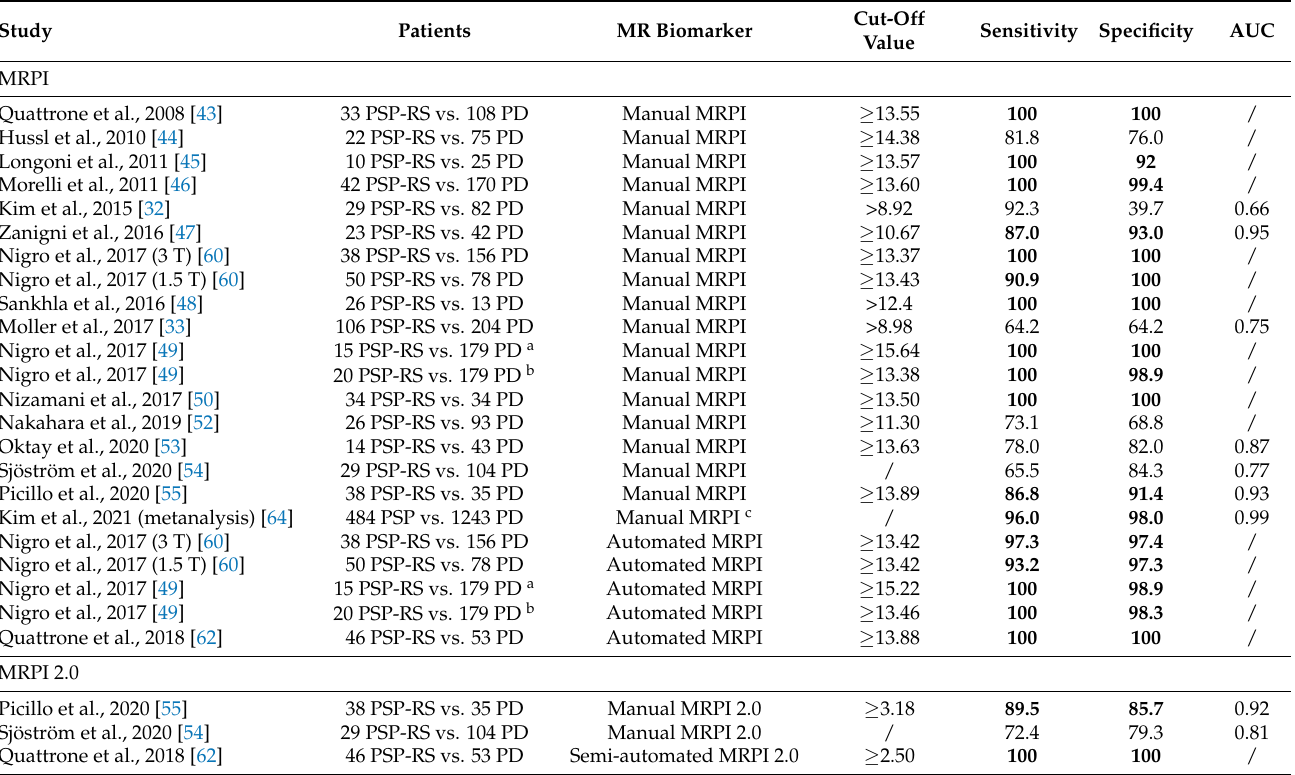
Note to Table 2: Studies showing both sensitivity and specificity above 80% are highlighted in bold. Studies aiming to differentiate PSP from MSA or non-PSP patients (including combinations of PD, MSA, and controls) and studies with sample sizes smaller than 10 patients were not included in the table. Abbreviations: PSP-RS—progressive supranuclear palsy Richardson’s syndrome; PD—Parkinson’s disease; AUC—area under the receiver operating characteristic curve; MRPI—Magnetic Resonance Parkinsonism Index. a Probable PSP patients according